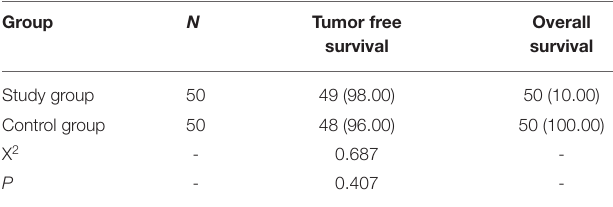
TABLE 7 | Comparison of 1-year follow-up outcomes between the two groups [n (%)].